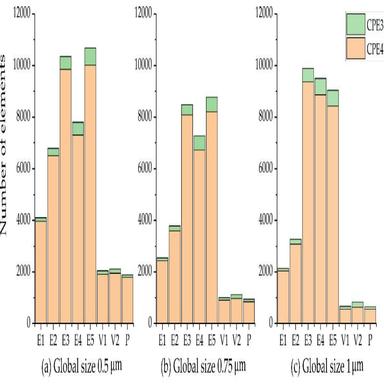
Element quantity comparisons of grain scale RVE models.